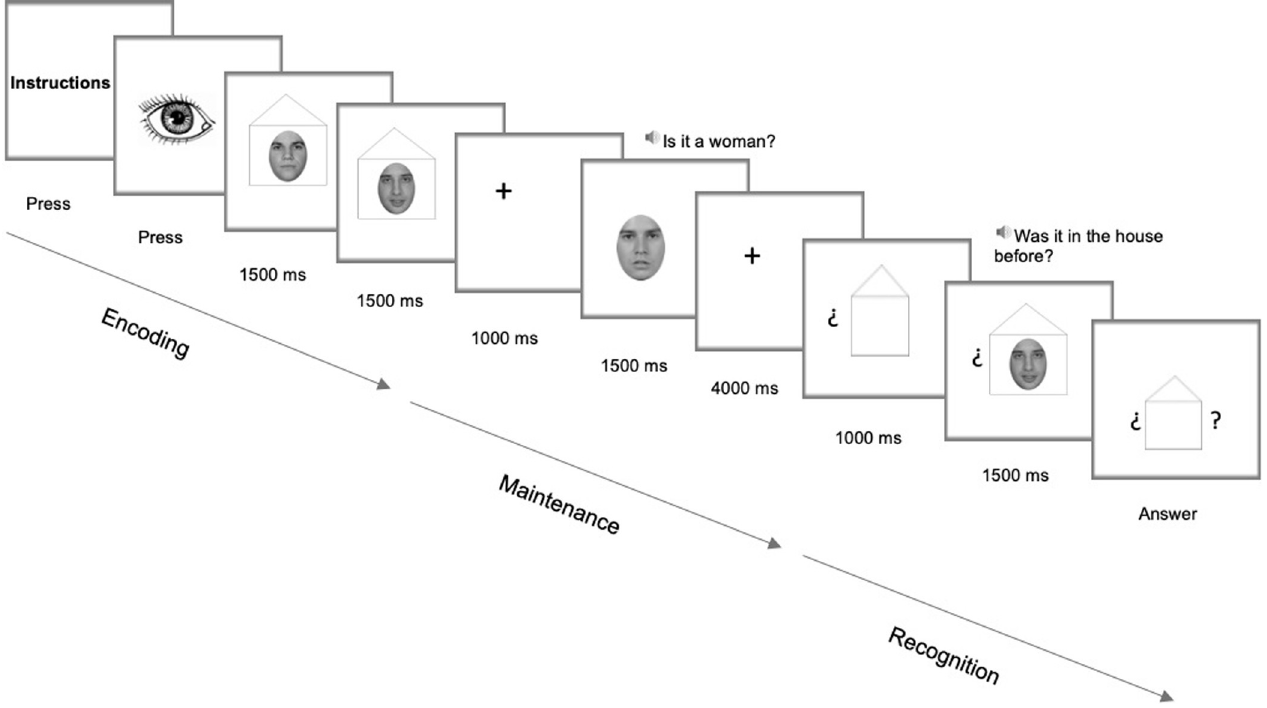
Fig 2. High-load condition with interference: With faces as stimuli.